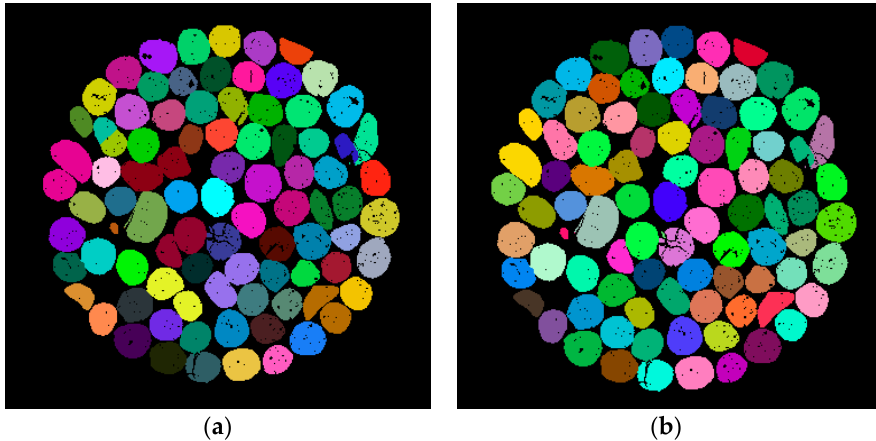
Figure 14. Example of quality metrics Q depending on parameters delta_h and max_filter_size .